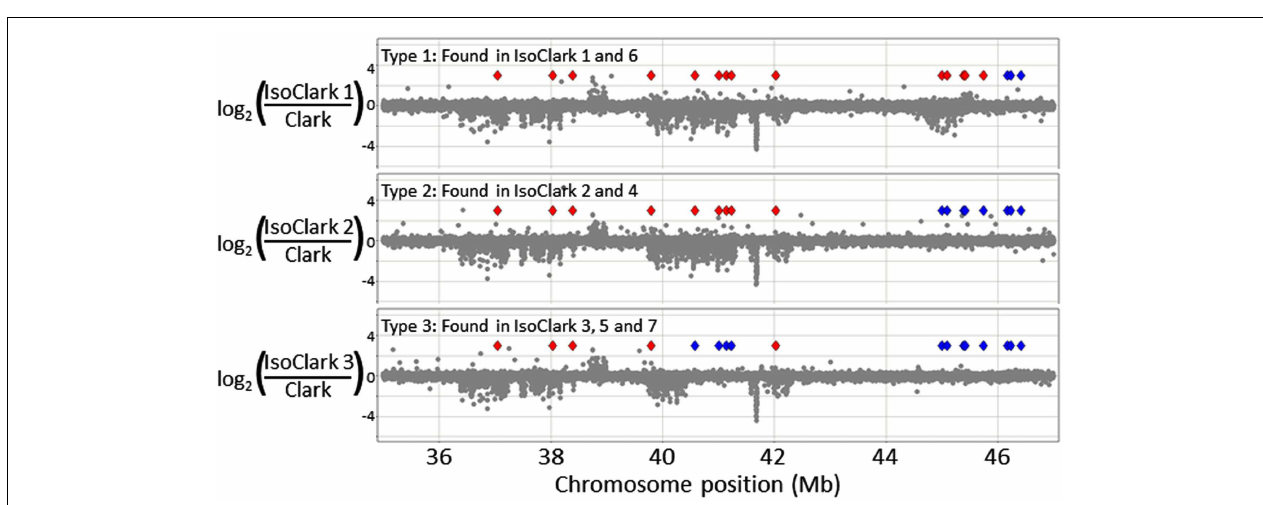
structural variation (UpCNV and DownCNV) relative to the “Clark” control. Haplotype 1 (top) appears to be a continuous ∼ 10Mb introgression of “T203,” haplotype 2 appears to be a smaller ( ∼ 6–8Mb) introgression, and haplotype three appears to be a quadruple recombinant where part of the introgression is interrupted by the “Clark” haplotype (at position ∼